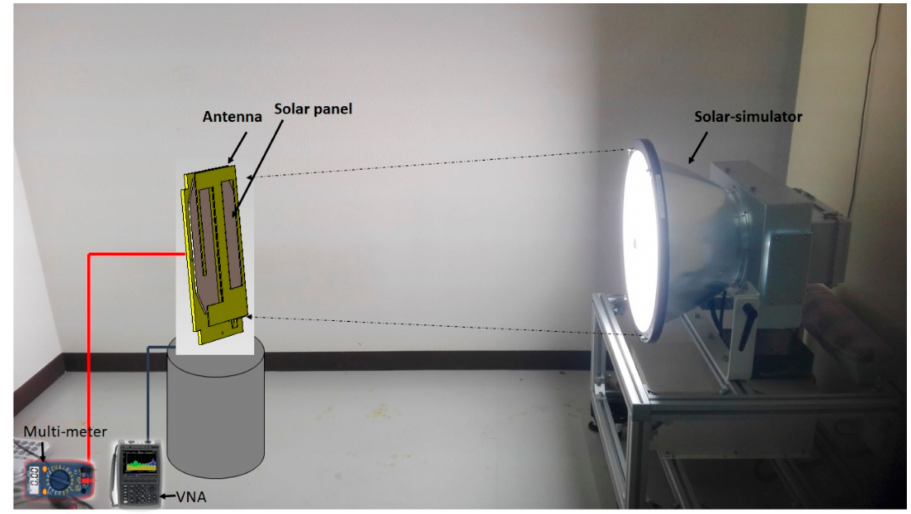
Figure 10. Solar panel output power measurement setup. The components are: Solar-simulator, vector network analyzer (VNA), Multi-meter and the proposed Antenna. The output power measurement was conducted using a fixed